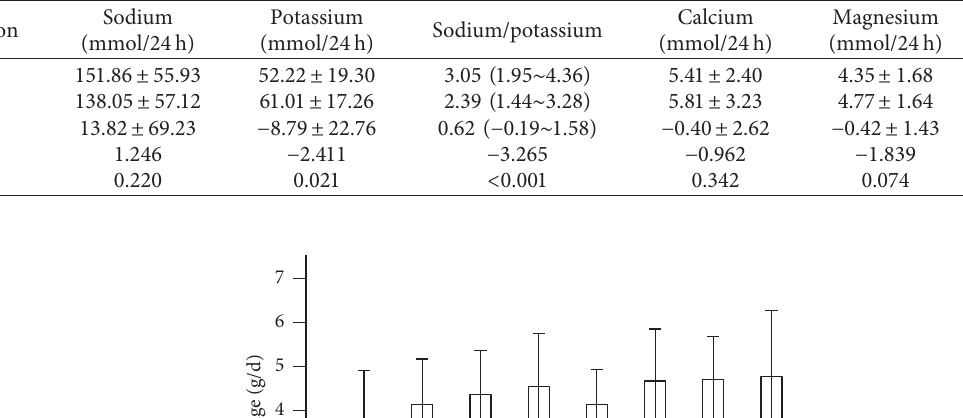
Table 2: Changes of the 24-hour urine test before and after intervention.